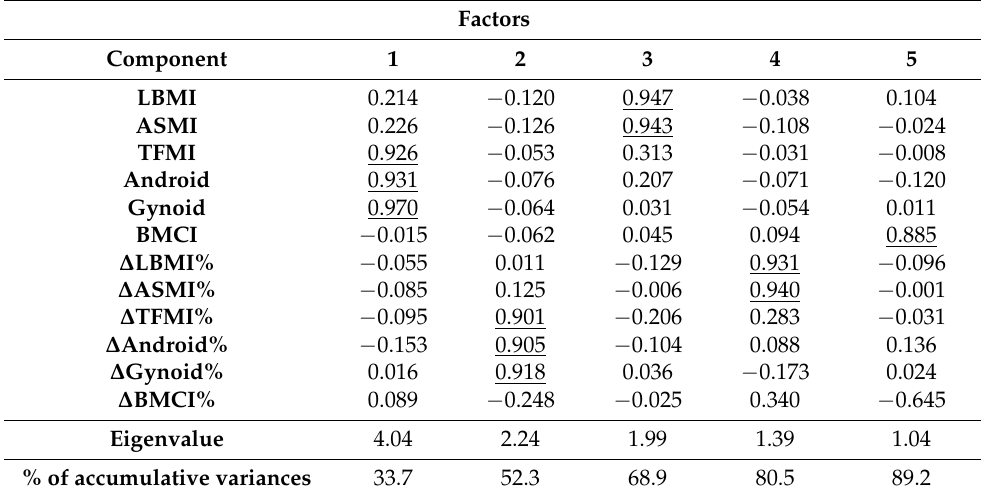
Table 2. Factor analysis results of DXA-related parameters among 69 patients following postoperative CCRT completion.